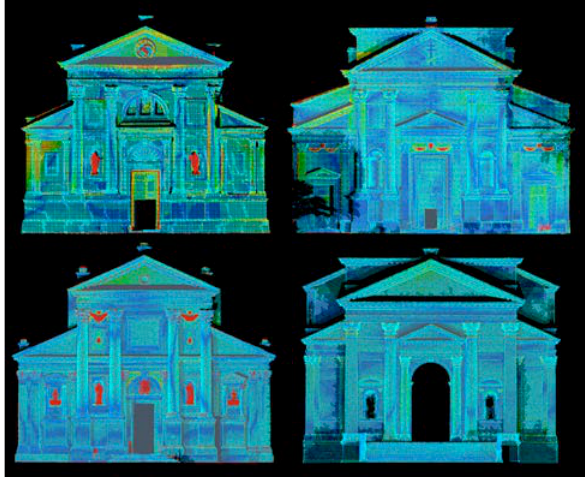
Figure 6. The Palladian churches in Venice: false color comparison between data acquired and the model for